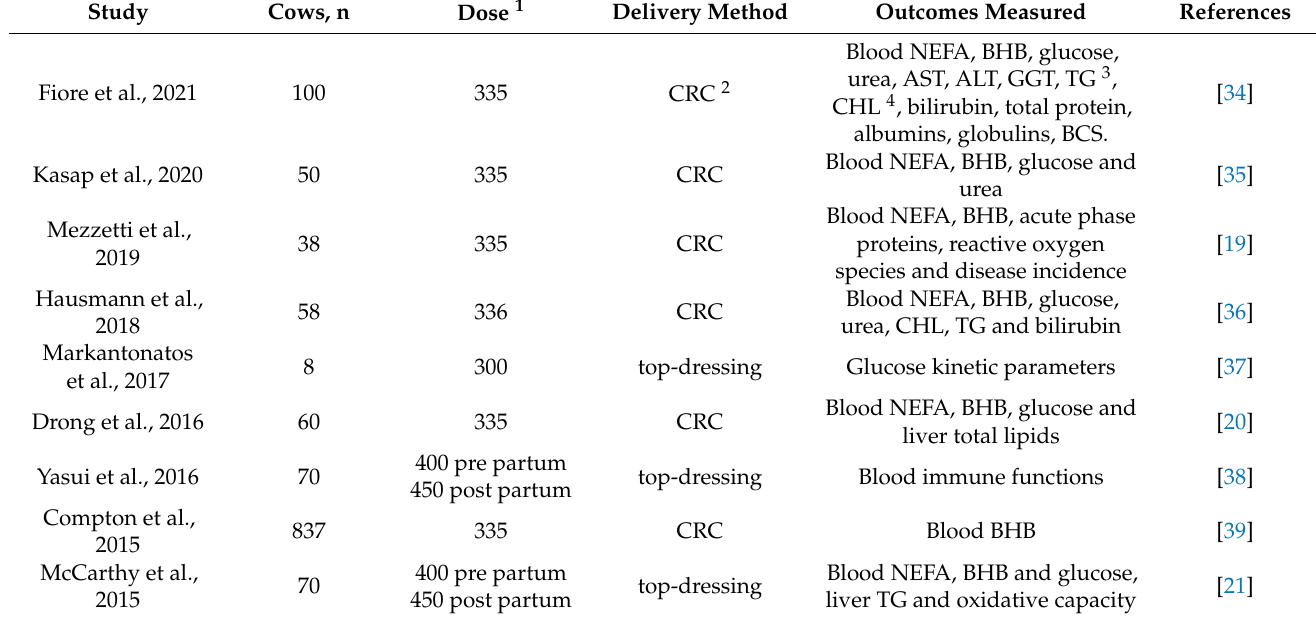
Table 2. Studies evaluating the effect of monensin during transition period on metabolism and